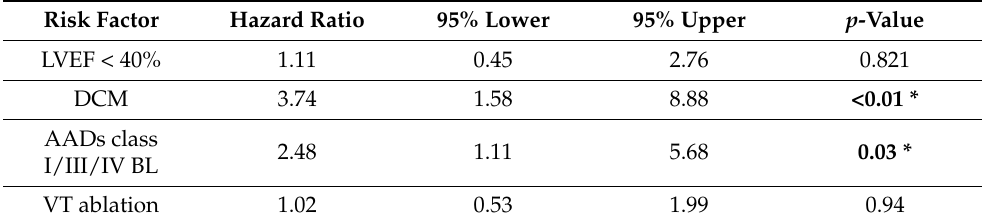
Table 3. Multivariate Cox regression analysis of risk factors for VA recurrence of patients undergoing RMN ablation.